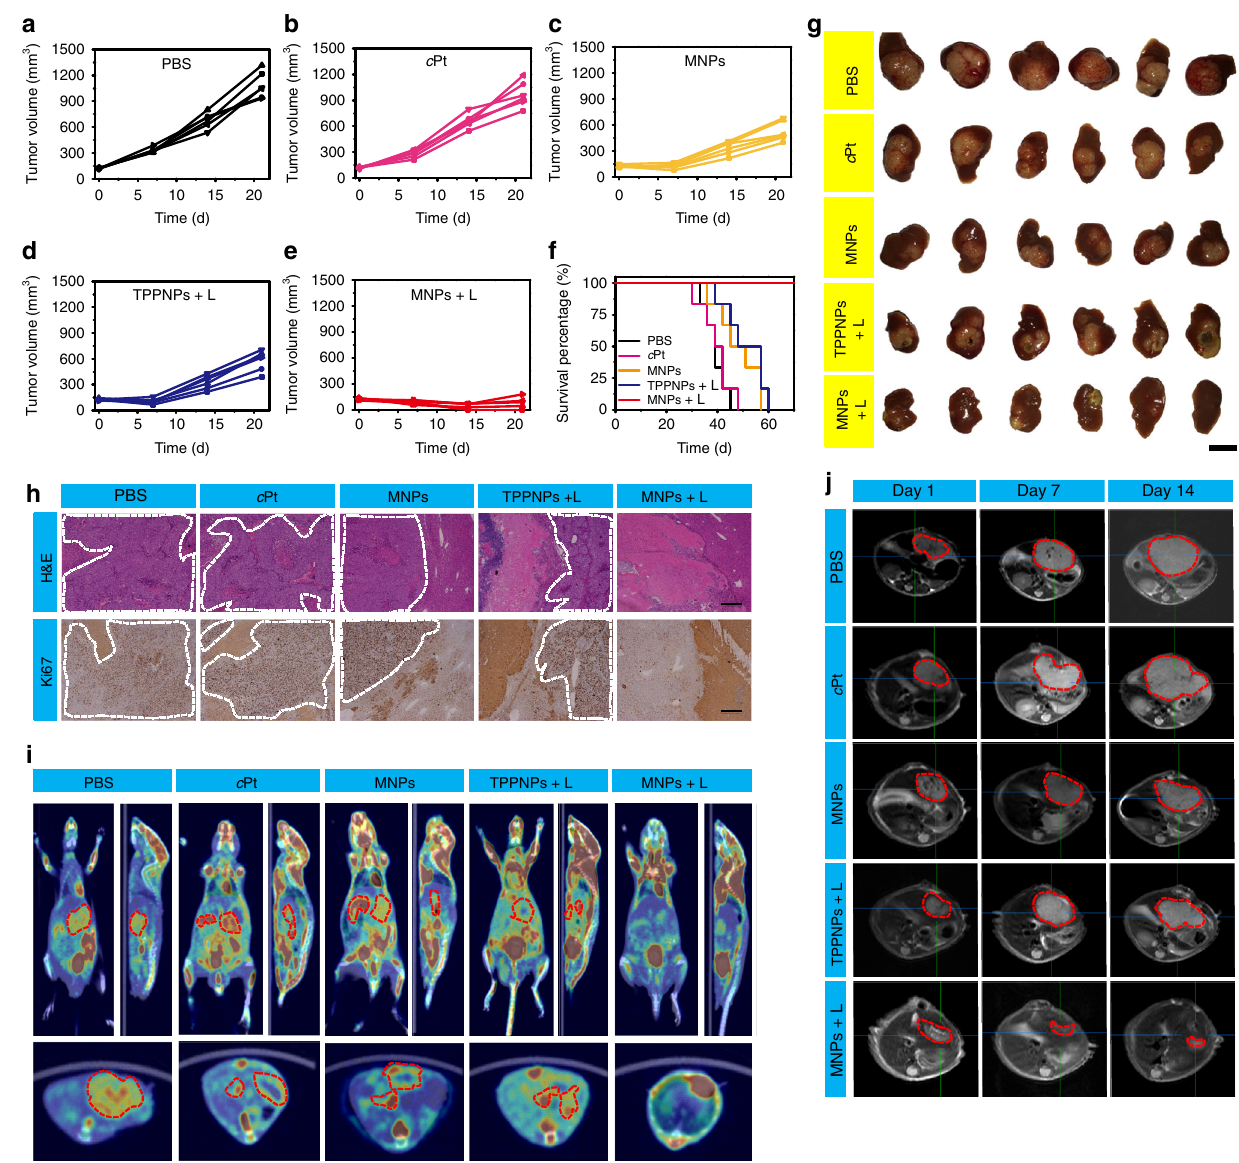
Fig. 9 Treatment of orthotopic liver cancer. Tumor volume changes of the mice bearing orthotopic LM3 tumors treated with a PBS, b c Pt, c MNPs, d TPPNPs + L, or e MNPs + L after one injection ( n = 6). f Kaplan – Meier survival curves of the mice bearing orthotopic LM3 tumors treated with different formulations. g Photo images of the liver tissues containing LM3 tumors collected from the mice treated with different formulations. h H&E and Ki67 staining of the liver tissues from each group. The white dashed circles denote the tumor tissues. Scale bar is 500 μ M. i PET/CT images of the mice treated with different formulations. The red dash circles denote the orthotopic hepatocellular carcinoma tumors. ( j ) MRI images of the mice treated with different formulations. The red dashed circles denote the orthotopic hepatocellular carcinoma tumors. The laser density was 0.3 W cm – 2 at 671 nm, and the irradiation time was 10 min. The data are expressed as means ±